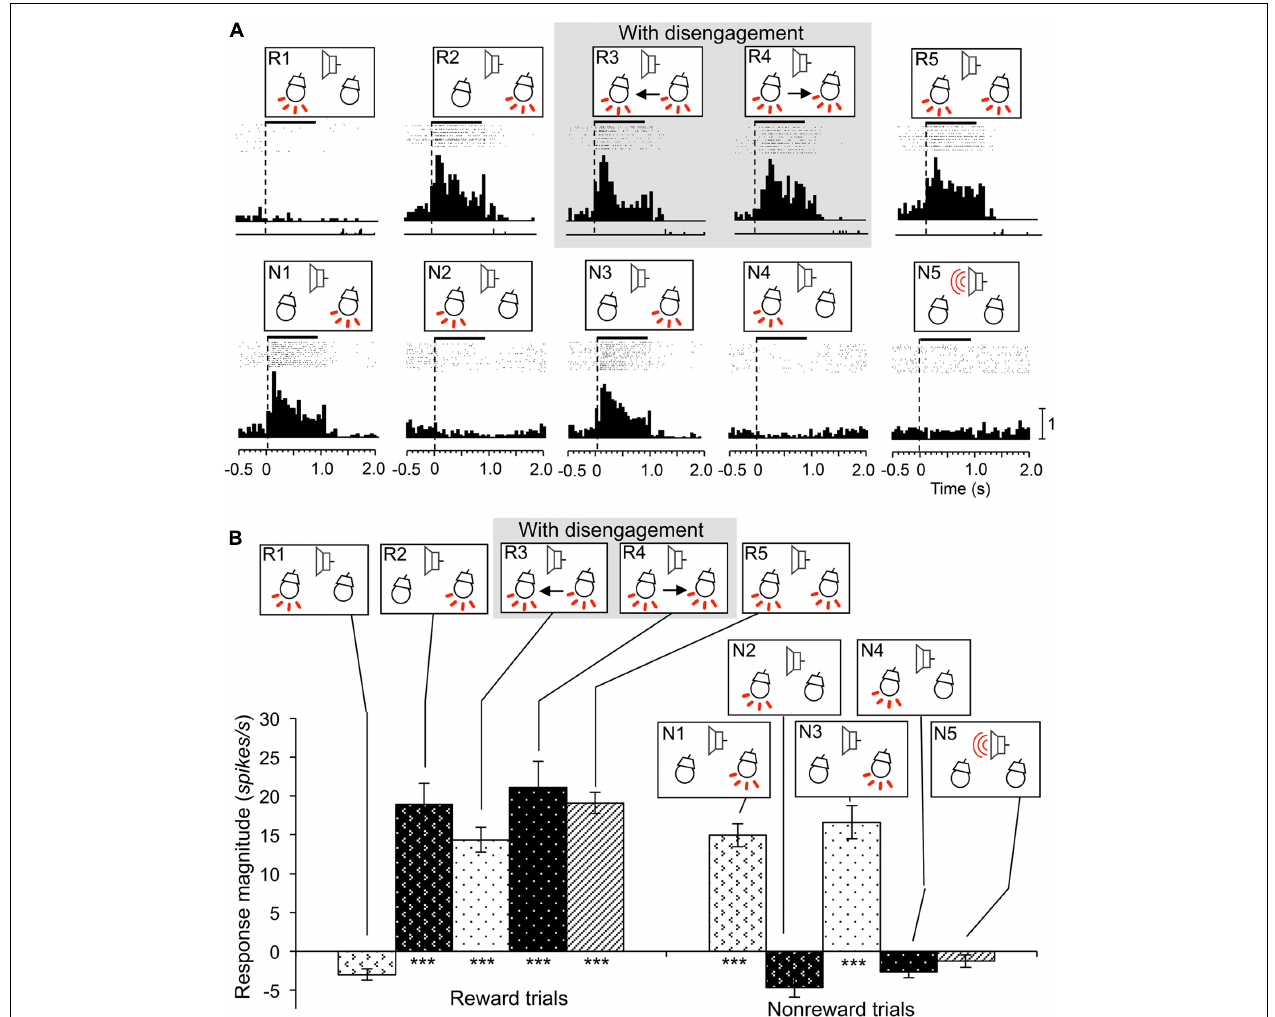
FIGURE 7 |An example of a visually responsive neuron recorded from the left SC. (A) Raster displays of neuronal activity and summed histograms in response to each stimulus. The neuron responded to the all CSs that included right light regardless of the session and reward